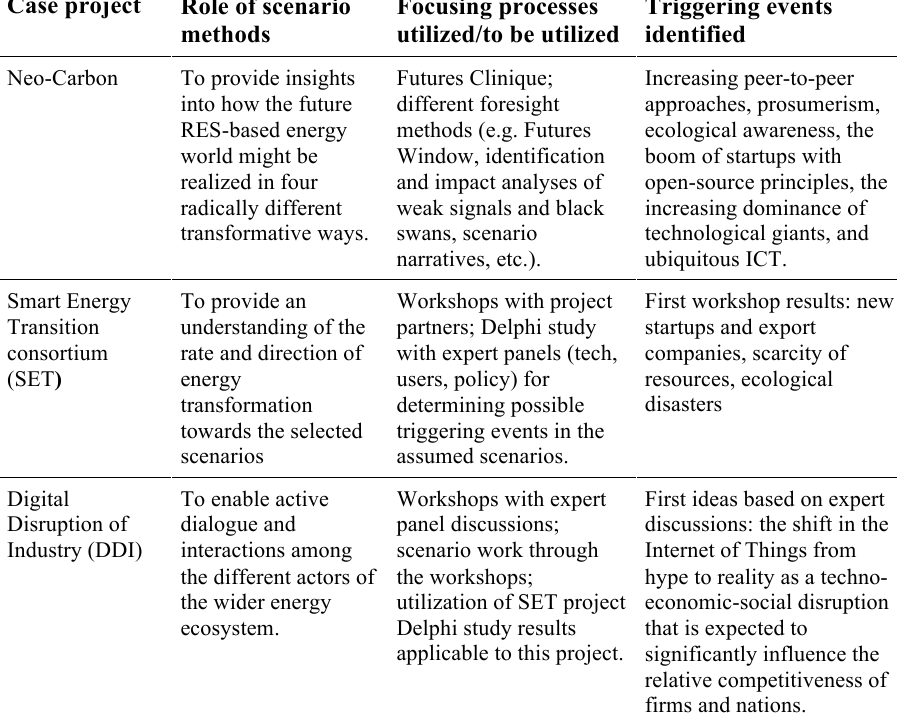
Table 1. Illustrative examples of focusing processes and triggering events in case